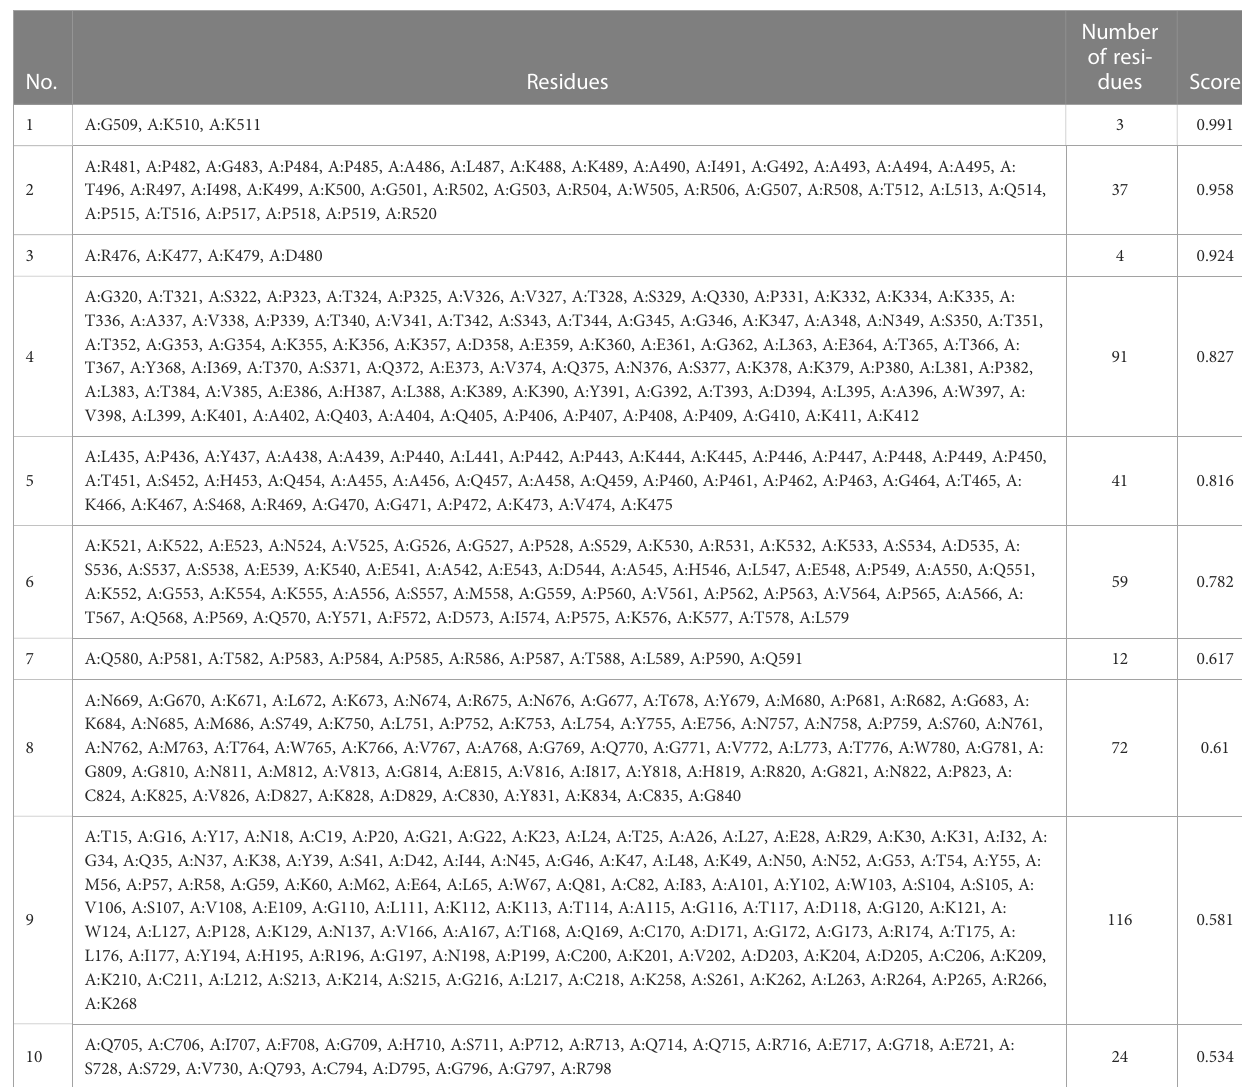
peptides for presentation on the cell surface in an MHC-II limited immunogen presentation, targets the Lysine linker. It also helps to reduce junctional immunogenicity by preventing the production of antibodies against the peptide sequence that can occur when separate epitopes are linked linearly (33). Immunogenicity is also boosted by KK linkers (34, 35). TABLE 11 Information of